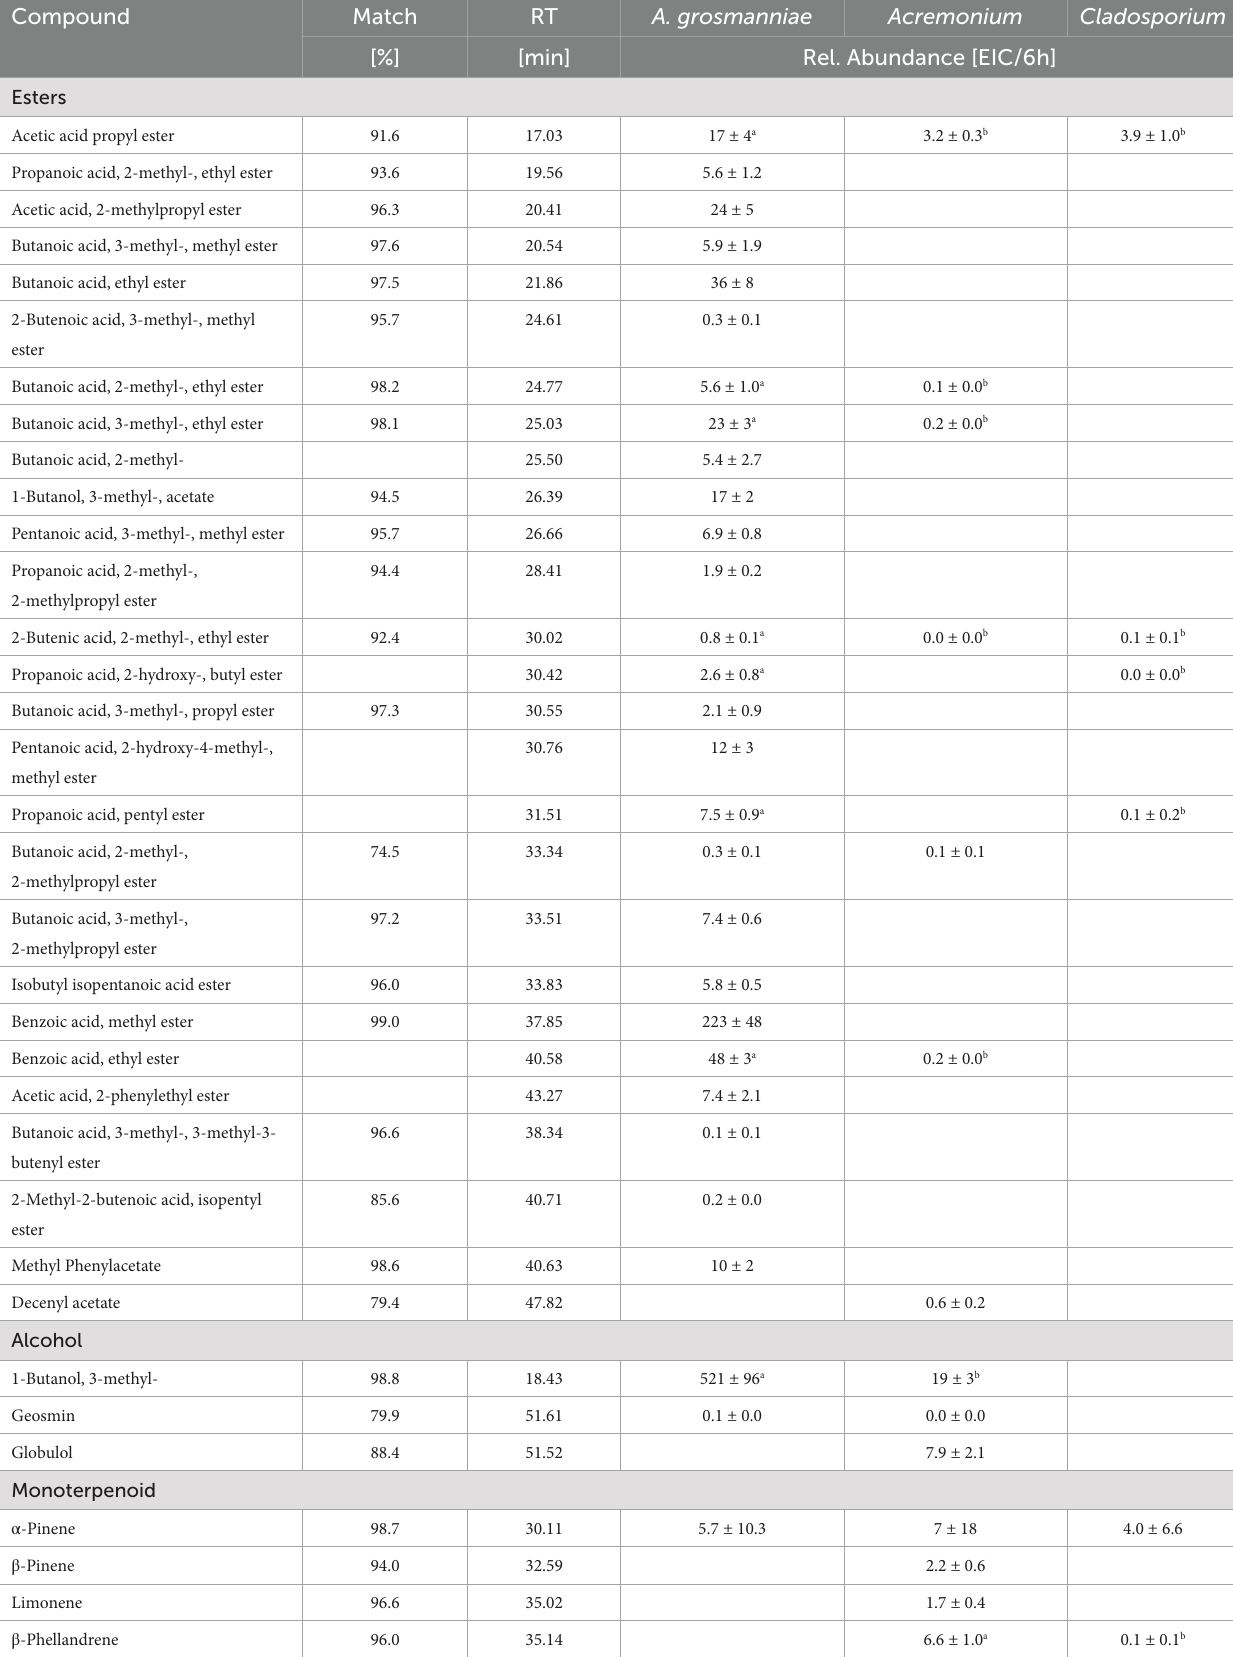
TABLE 1 MVOCs emitted from fungi isolated from X. germanus and grown for 6 days on Petri dishes. Compound Match